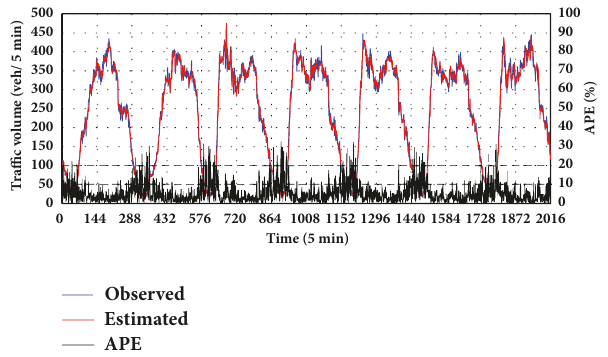
Figure 10: Temporal comparison of actual and estimated traffic volumes.